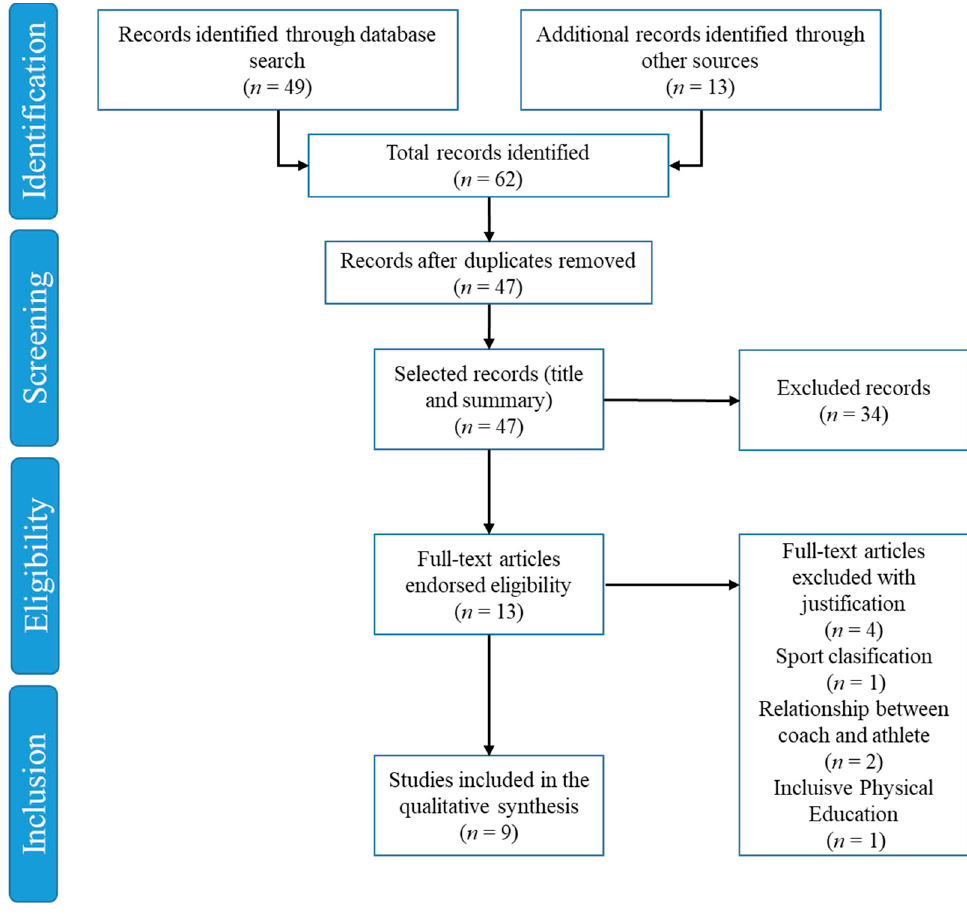
Figure 1. Study selection process using the PRISMA flowchart.